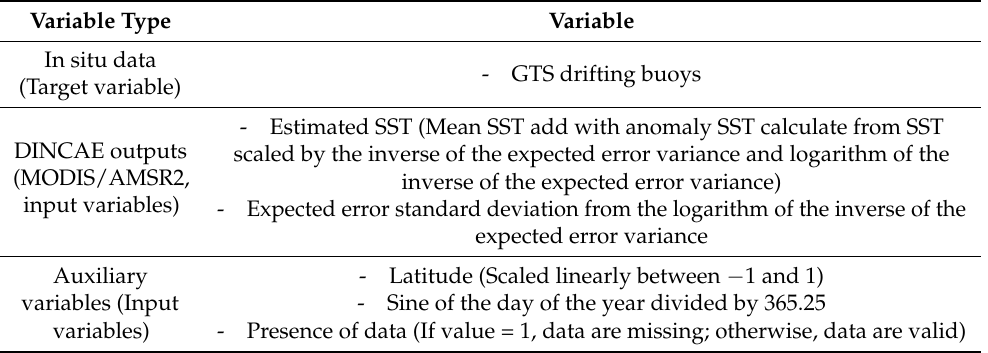
Table 3. Summary of the input variables used in the random forest model to further improve the reconstructed SSTs through data